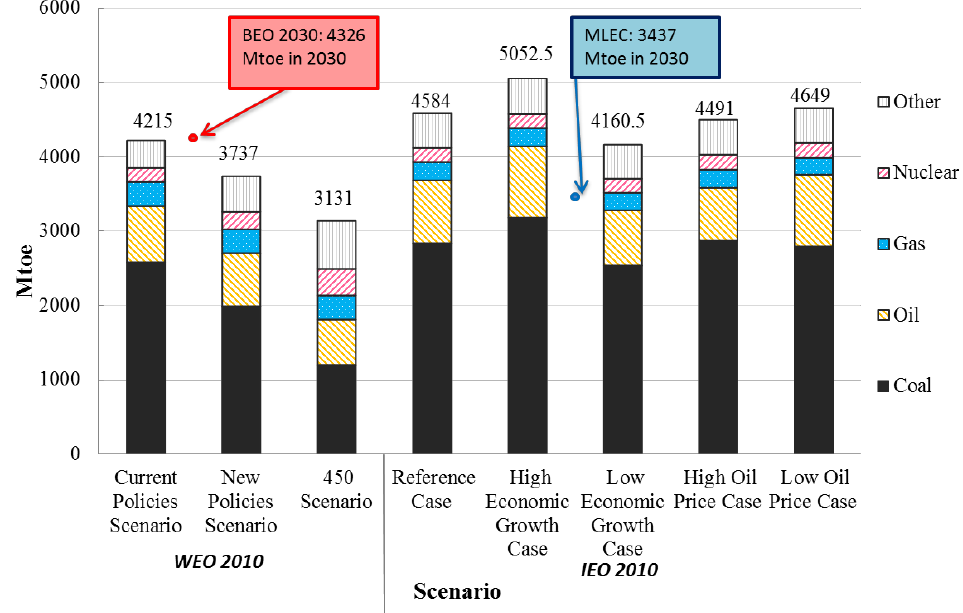
Figure 4. A comparison of projections of primary energy demand of China,